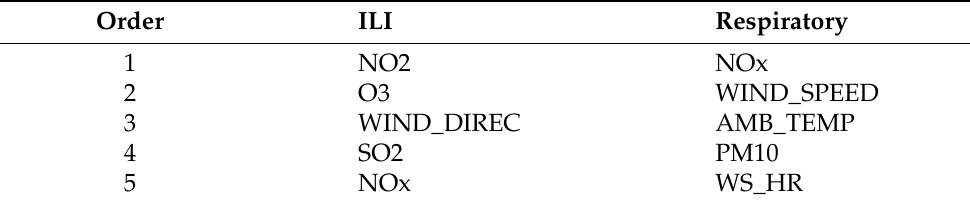
Table 3 listed the chemical correlation of feature selection for ILI and Respiratory disease. Table 2. Extra Trees Classifier of ILI and Respiratory.